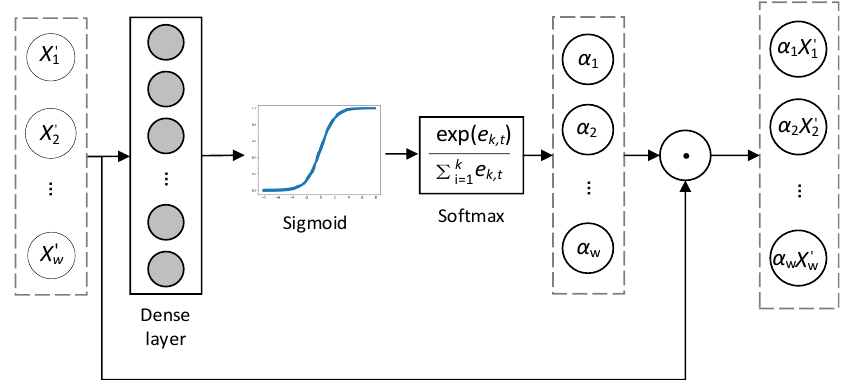
Figure 2. Architecture of feature attention mechanism.